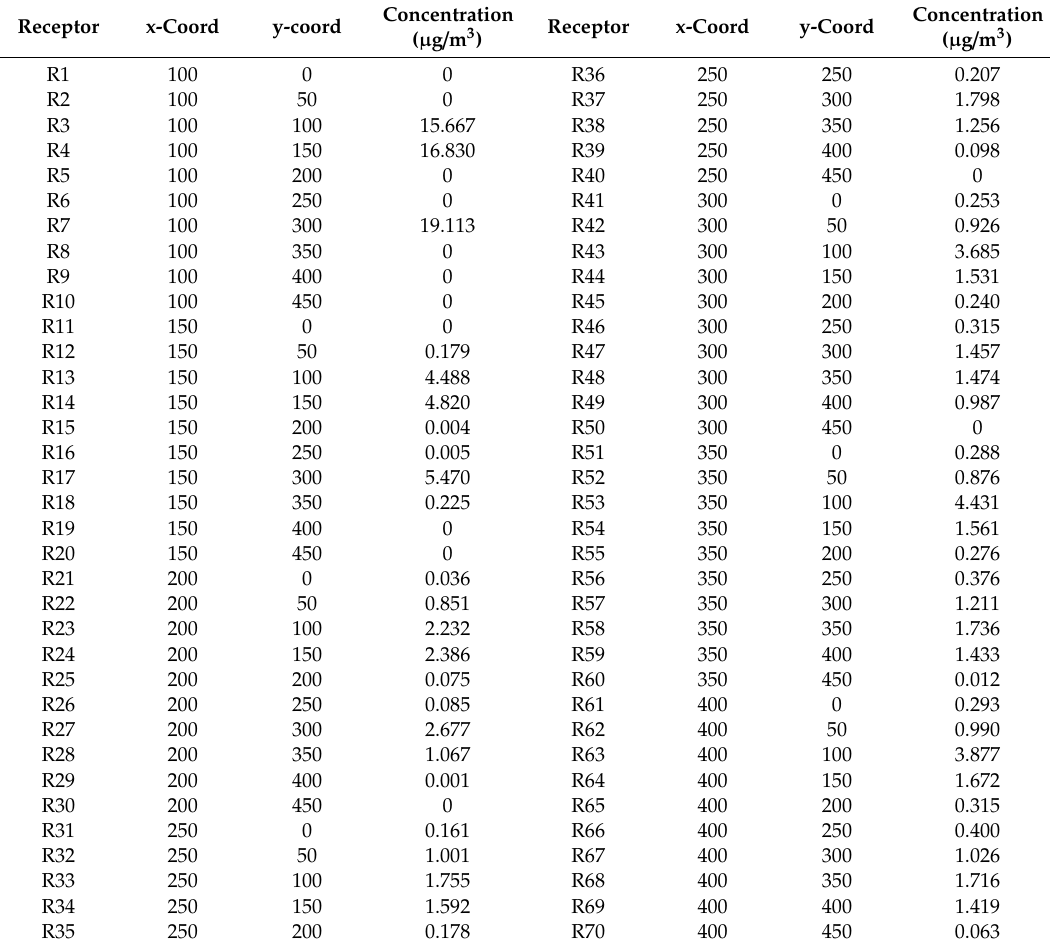
Table 2. Receptor locations and concentrations as calculated in Step